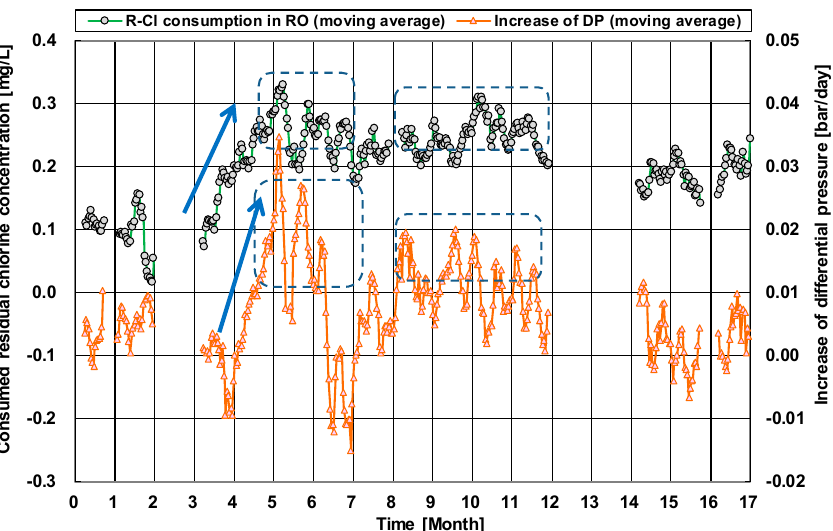
Figure 13. The differential pressure (DP) of the RO module used in a seawater reverse osmosis (SWRO) plant at the Arabian Gulf, and the tendency of chlorine consumption in the RO module during ICI. The target residual chlorine concentration was set to 0.5 mg/L, and its injection time and its frequency were set to once every 24 h where each time was 1 h. Data from [90].